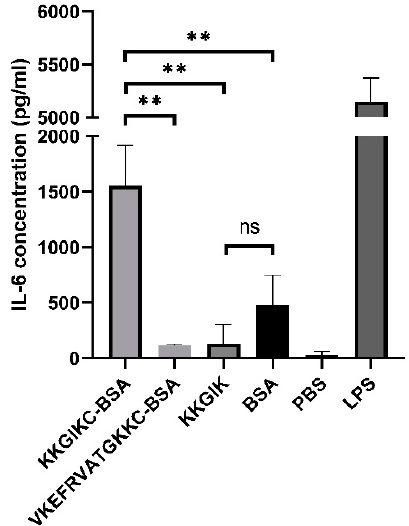
Figure 8. Stimulation of TC-1 epithelial cells with conjugate KKGIKC-BSA (10 µg/mL), BSA (10 µg/mL), KKGIK (10 µg/mL), VKEFRVATGKKC-BSA (10 µg/mL), and LPS (1 µg/mL, positive control).